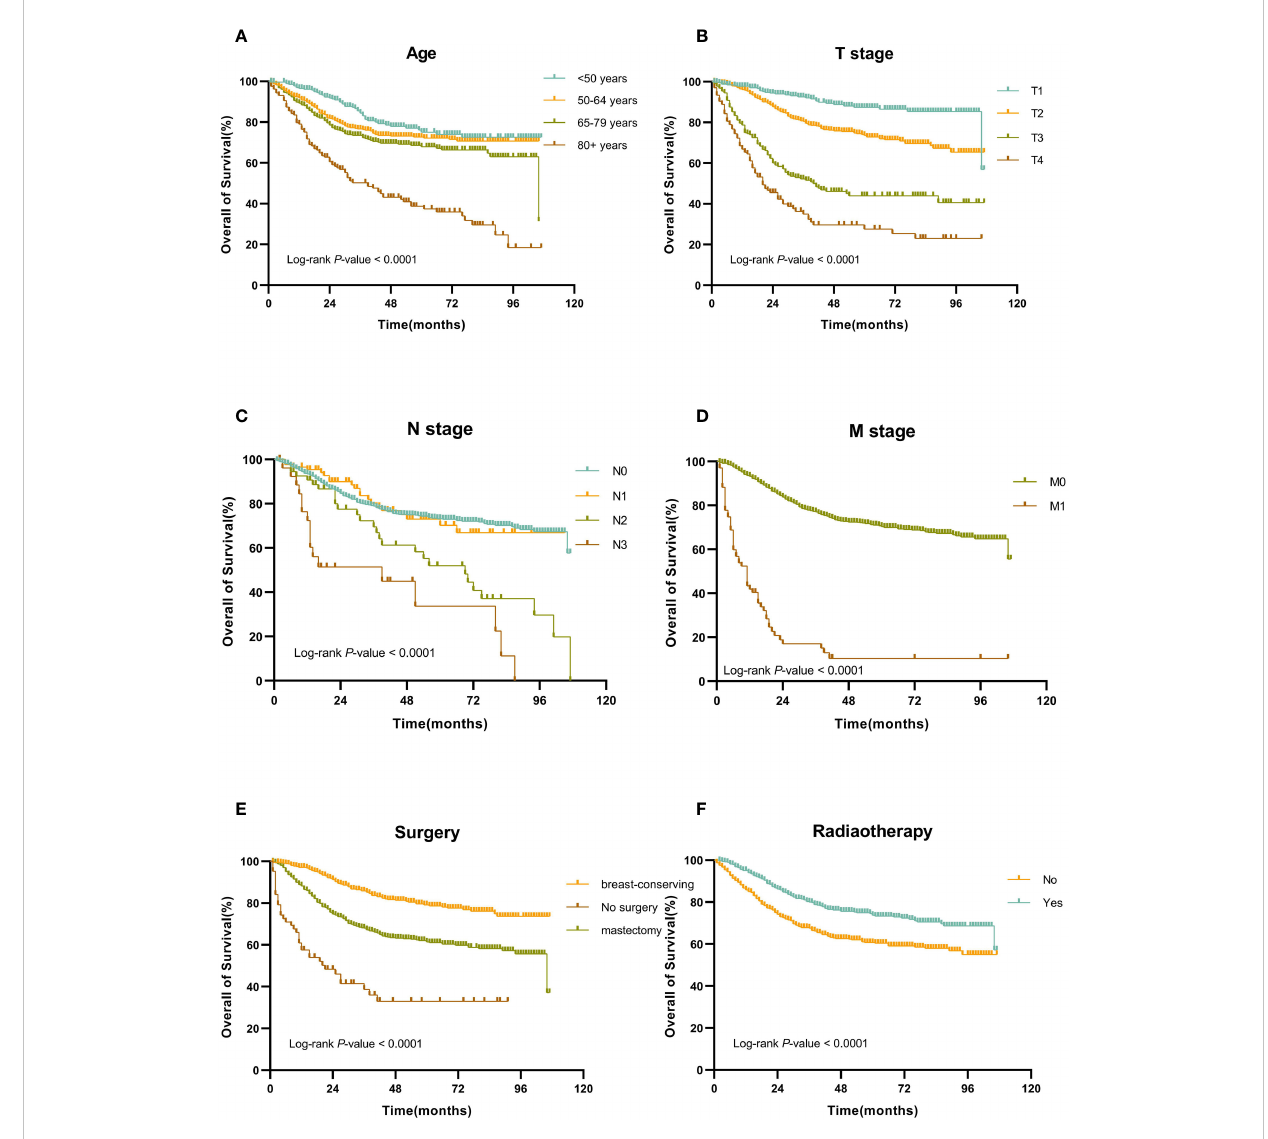
FIGURE 2 Kaplan-Meier OS curves for patients with MBC according to different independent prognostic factors. (A-F) Kaplan-Meier OS curves for patients with MBC according to (A) age, (B) T stage, (C) N stage, (D) M stage, (E) surgery, and (F)